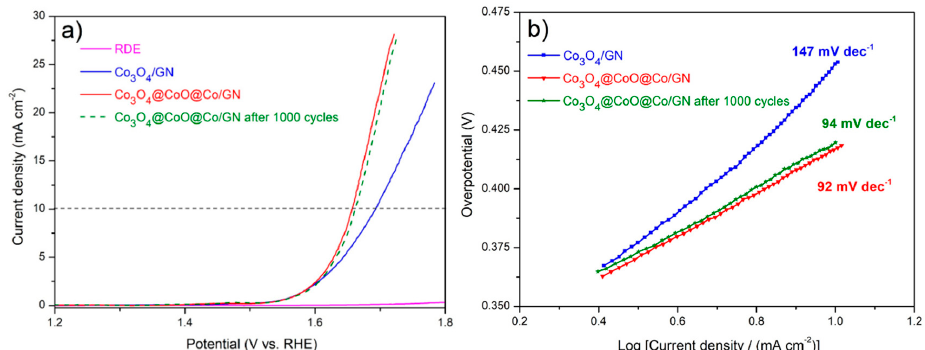
Figure 4. ( a ) The initial oxygen revolution reaction (OER) i -V curves for rotating disc electrode (RDE), Co 3 O 4 /GN, and Co 3 O 4 @CoO@Co/GN (before and after 1000 cyclic voltammetric (CV) cycles). ( b ) The Tafel plots for Co 3 O 4 /GN and Co 3 O 4 @CoO@Co/GN (before and after 1000 CV cycles).